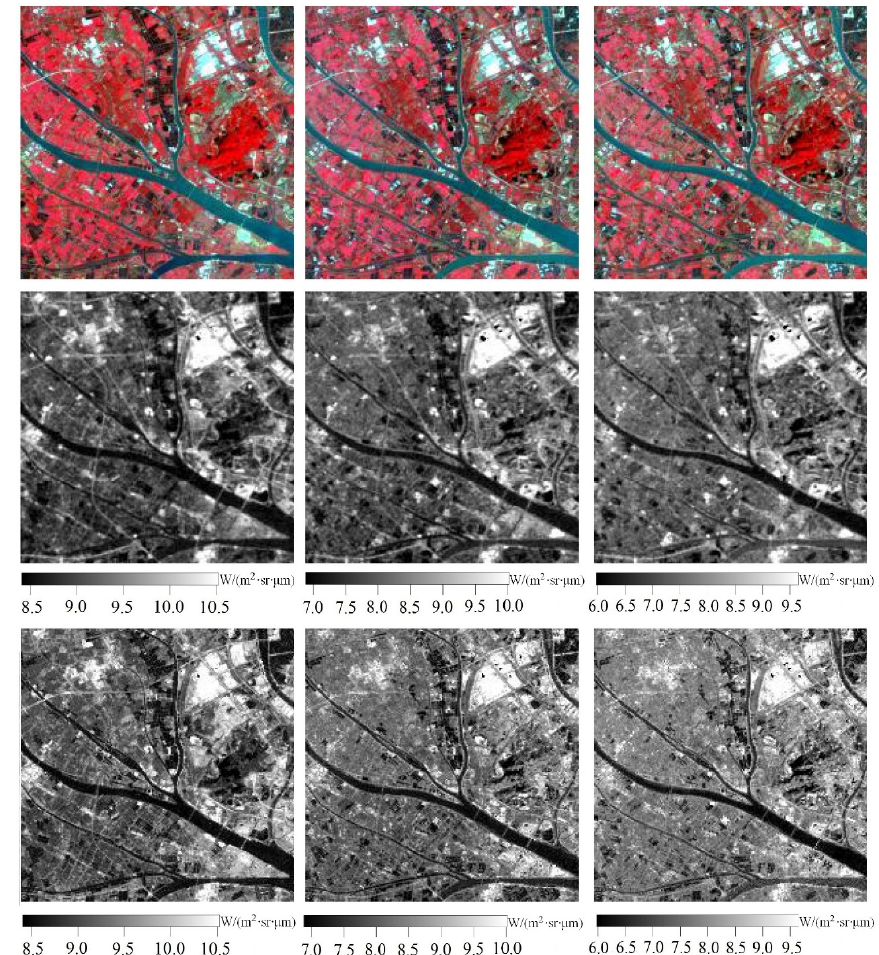
Figure 5. Thermal spatial sharpening results of testing experiments via ELM algorithm. False colour images of downscaled Landsat ETM+ multispectral data at 60 m ( upper row ), downscaled TIR images at 120 m ( middle row ) and sharpened TIR images at 60 m ( lower row ). The original TIR images at 60 m refer to the middle row in Figure 6. From left to right, they were acquired on 20 October, 7 December and 23 December